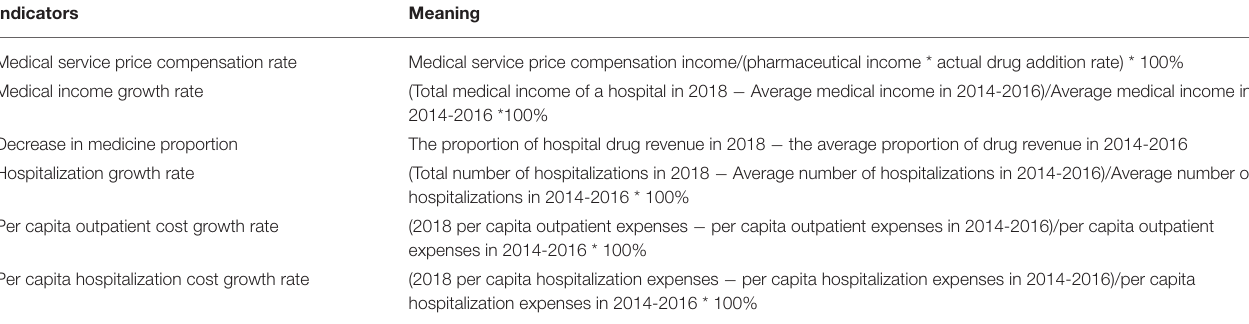
TABLE 1 | Performance evaluation indicators.